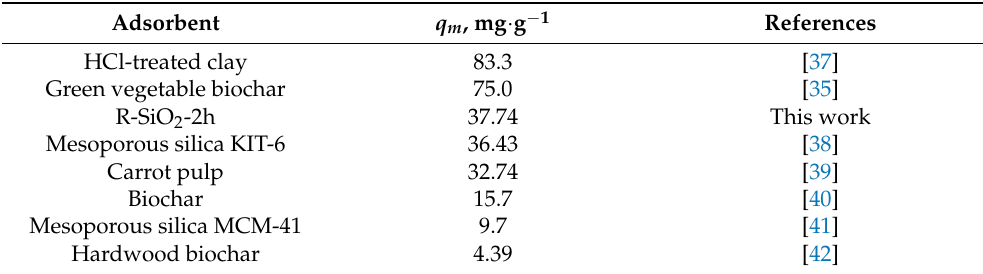
Table 5. Adsorption capacities of different adsorbents towards removal of copper(II) ions from aqua